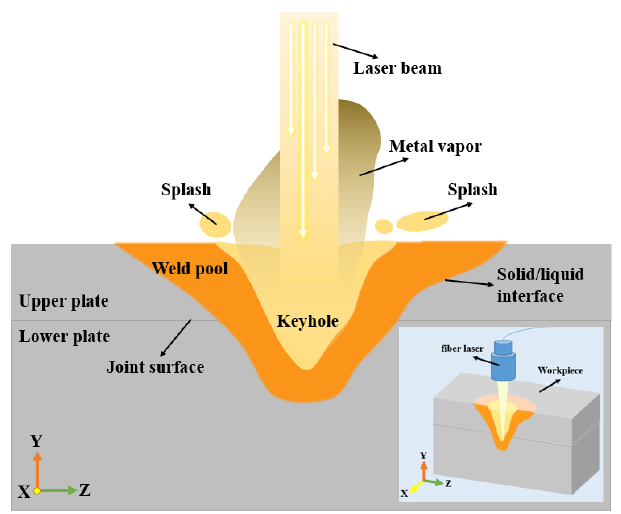
Figure 3. Schematic diagram of the LSMW model.